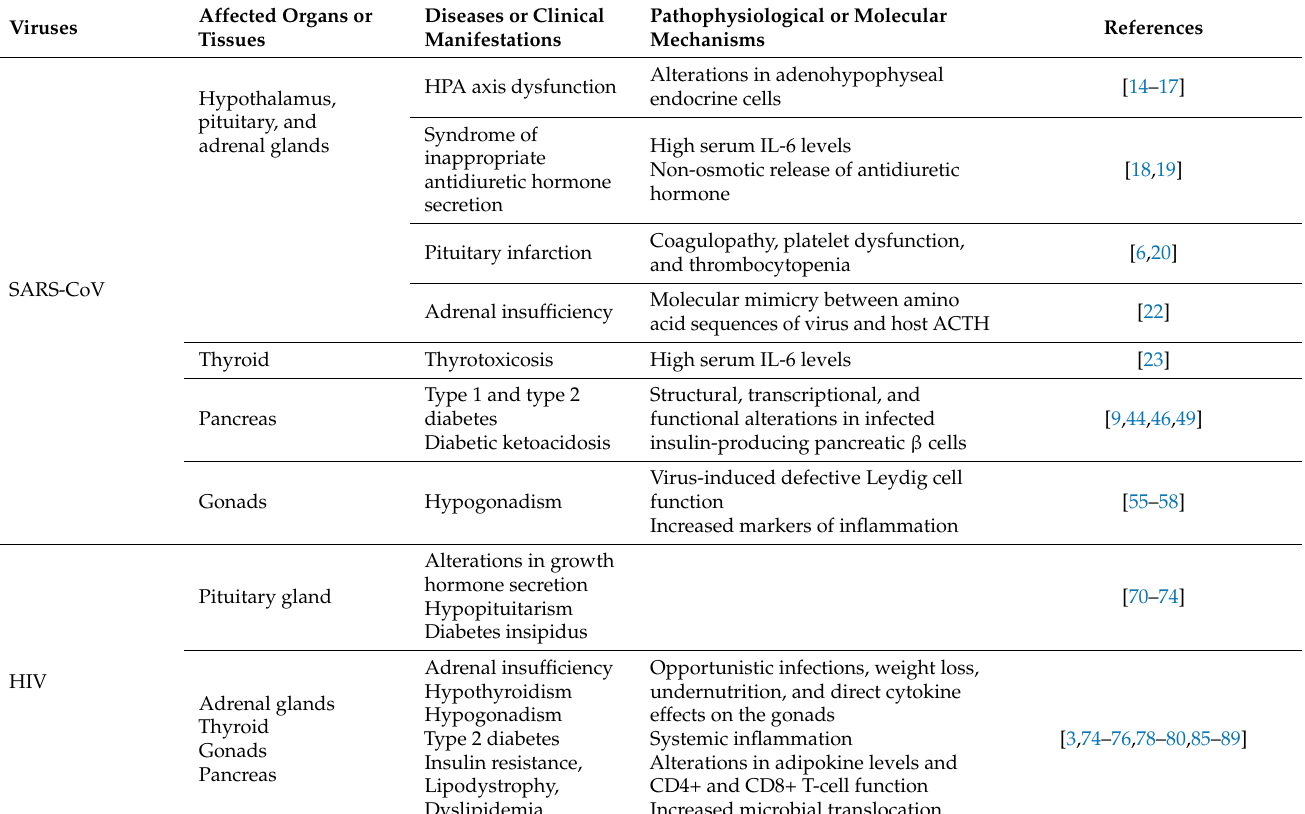
Table 1. Impacts of viruses on endocrine